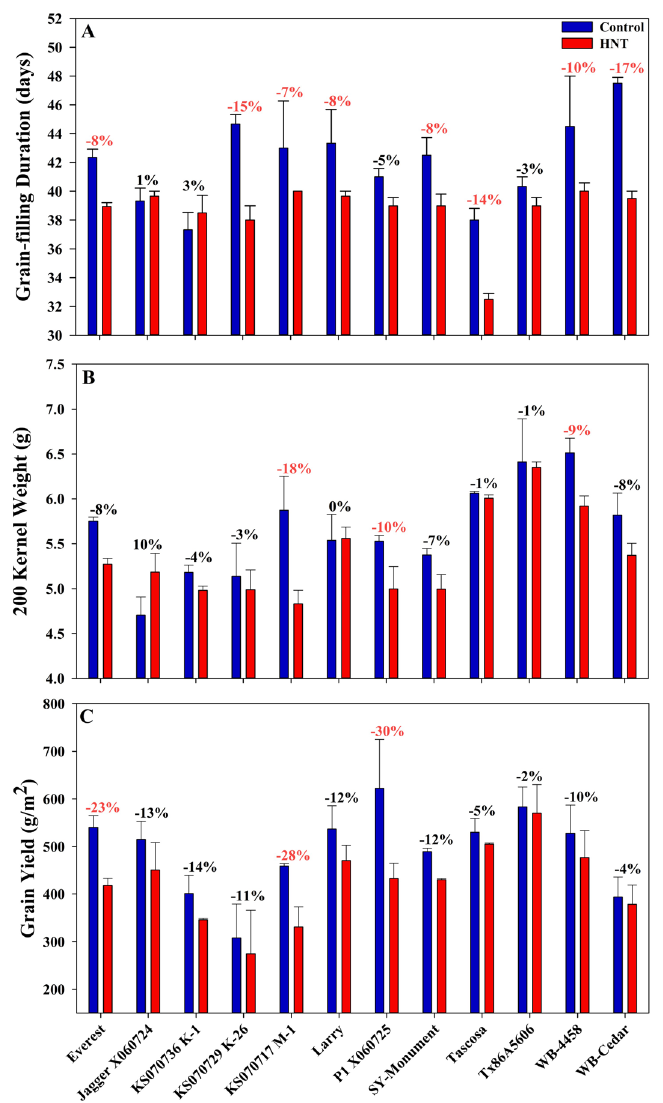
Figure 5. Agronomic response of wheat genotypes exposed to HNT stress during grain-filling. Grain-filling duration ( A ), 200 kernel weight ( B ) and grain yield ( C ) of 12 winter wheat genotypes exposed to HNT stress and control conditions for the entire grain-filling period. Reductions in red signify significant reduction (p <